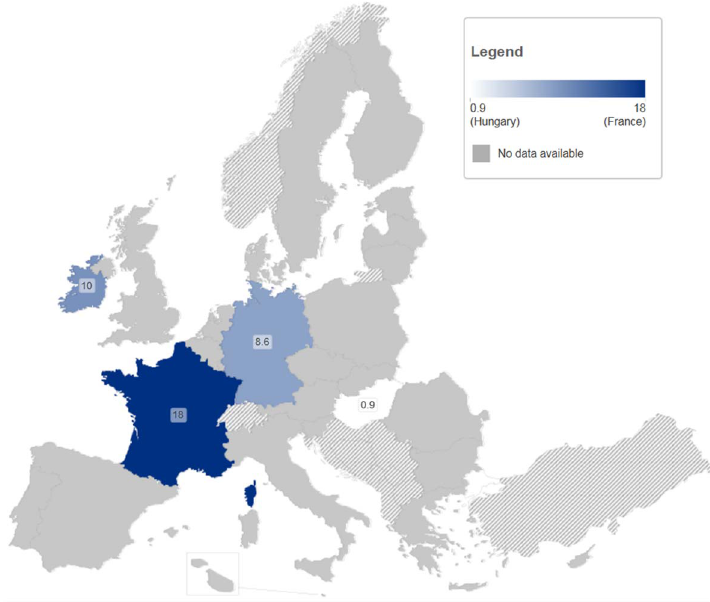
Figure 7. Proportion (%) of HCV-infected PWID entering antiviral treatment in observational studies in non-clinical settings.